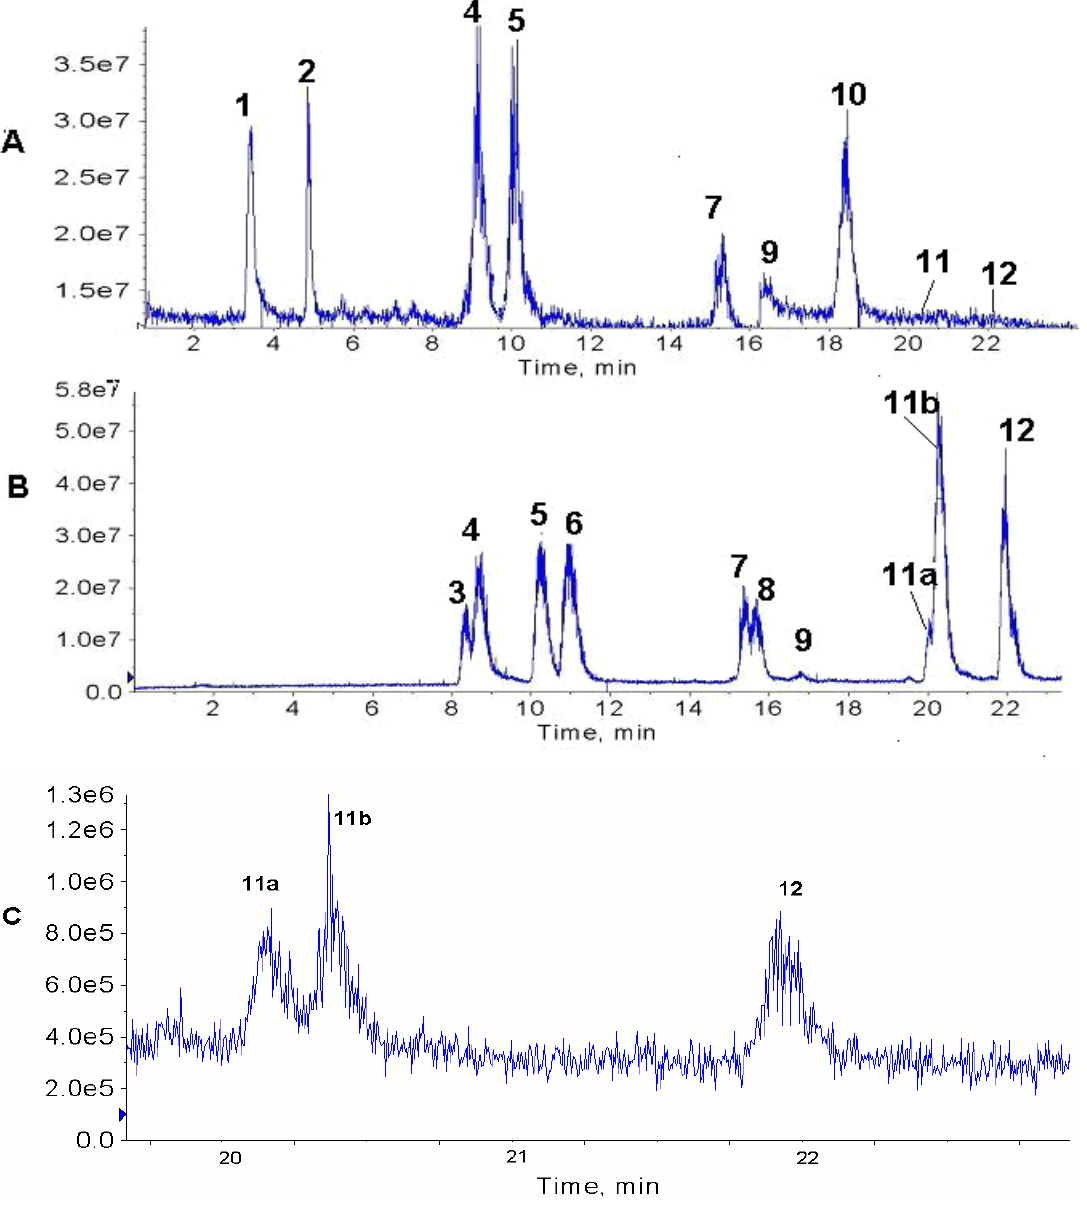
Figure 1. HPLC-MS TIC chromatograms of (A) jaborandi leaf extract and (B) paste extract. Numbered peaks correspond to: 1 m/z 202, 2 m/z 248, 3 isopilocarpine m/z 209, 4 pilocarpine m/z 209, 5 , pilosine m/z 287, 6 m/z 287, 7 m/z 287, 8 m/z 287, 9 m/z 287, 10 m/z 316, 11 3-hydroxymethyl-4-(3methyl-3H-imidazol-4-yl)1-phenyl-butan-1-one m/z 259, and 12 anhydropilosine m/z 269. (C) XIC of ions m/z 259 ( 11a and 11b ) and m/z 269 ( 12 ) from the leaf extract